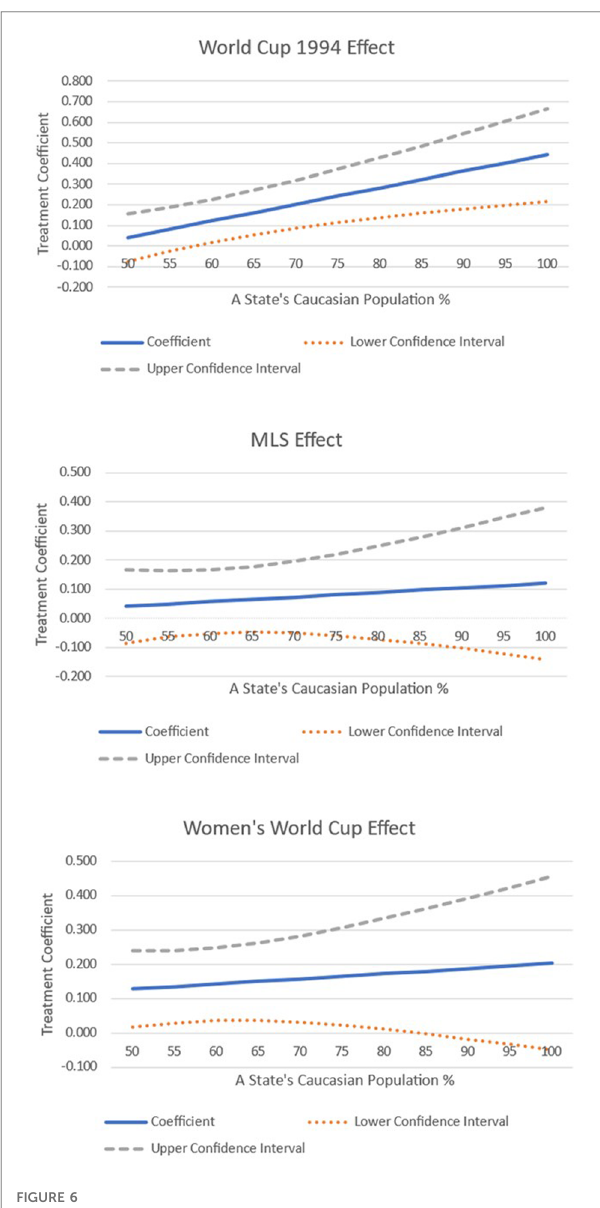
FIGURE 6 Interacting treatment effects with the size of a state ’ s Caucasian